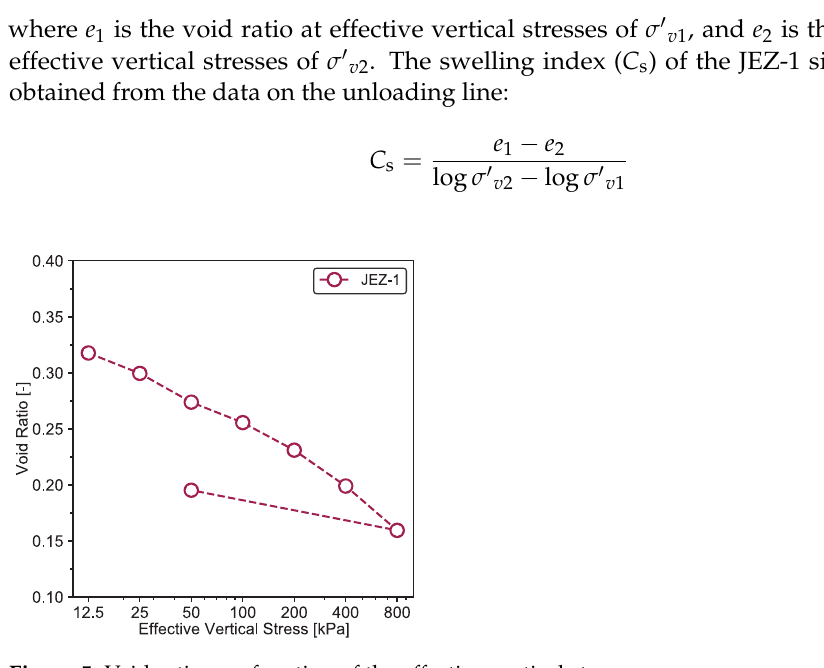
Figure 5. Void ratio as a function of the effective vertical stress.